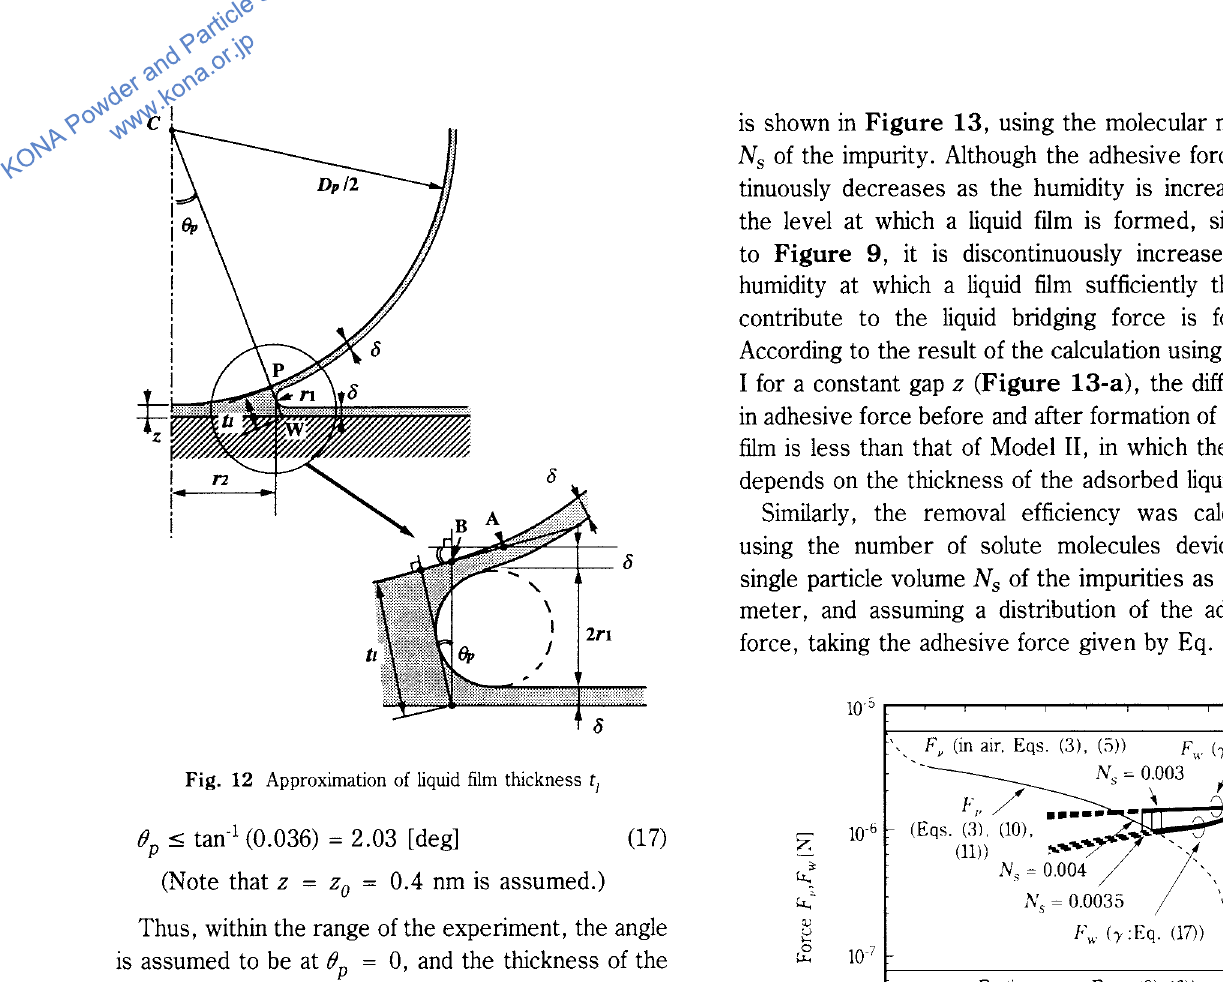
Fig. 12 Approximation of liquid film thickness t fJP ::5 tan· 1 (0.036) = 2.03 [deg] (17) = 0.4 nm is assumed.) (Note that z = z 0